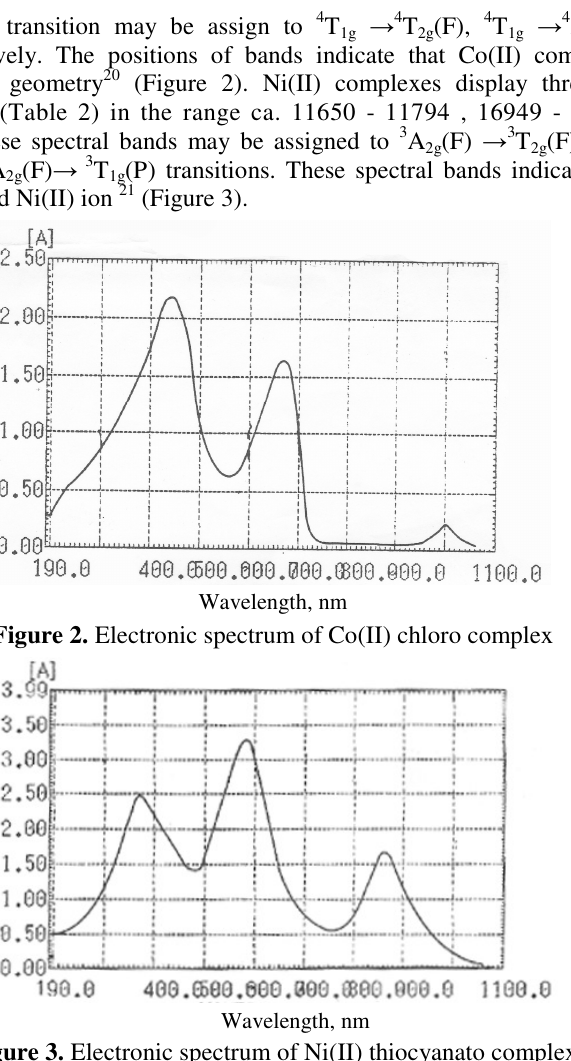
Figure 3. Electronic spectrum of Ni(II) thiocyanato